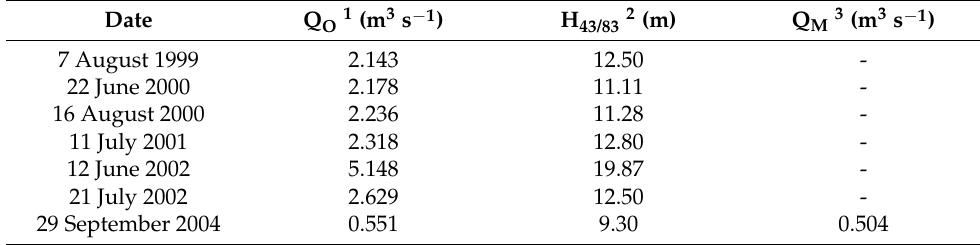
Table 5. Measured and estimated hydrological parameters in the Opatija region springs